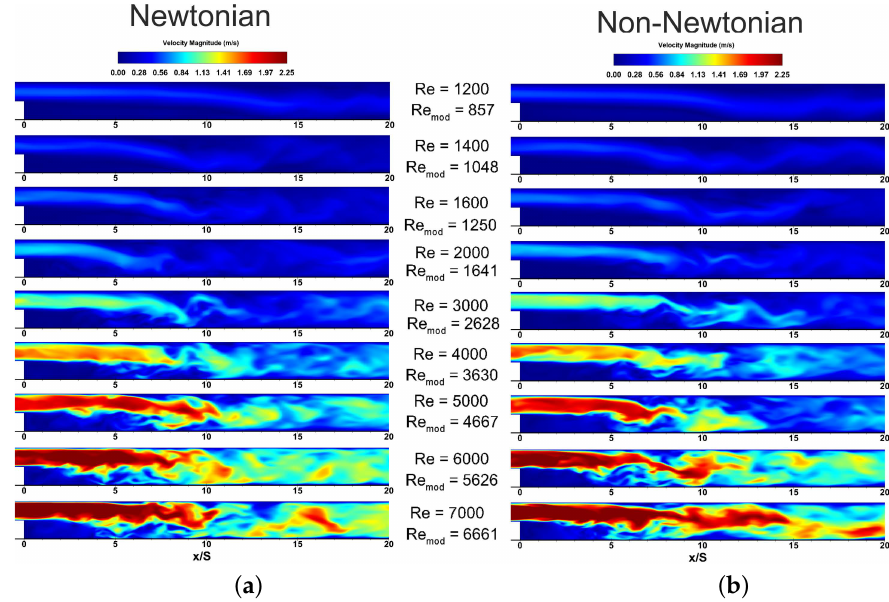
Figure 9. Instantaneous velocity magnitude contours for Newtonian blood rheology ( a ) and shear-thinning blood rheology ( b